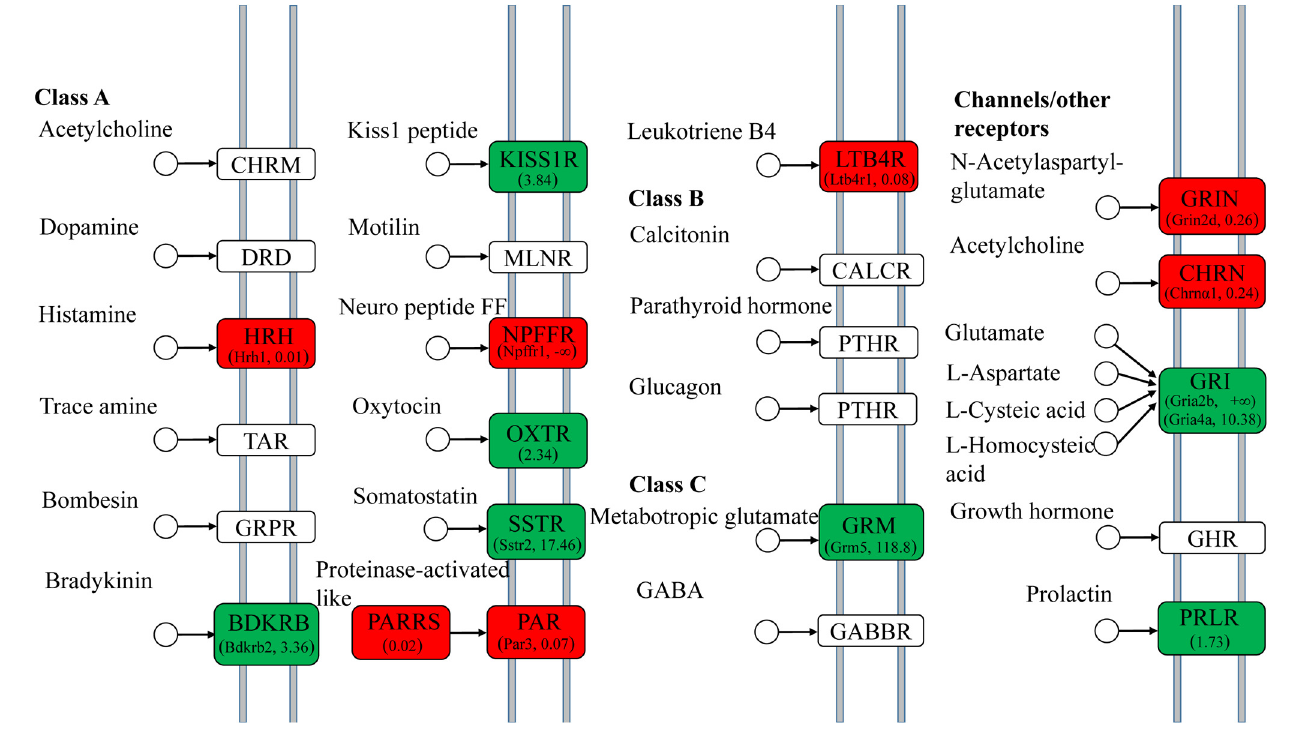
Fig 6. DEGs involved in the GPCR signaling pathway. YY highly expressed unigenes are shown in green and XY highly expressed unigenes are shown in red. The numbers in parentheses indicate the value of fold-change (RPKM value of XY/ RPKM value of